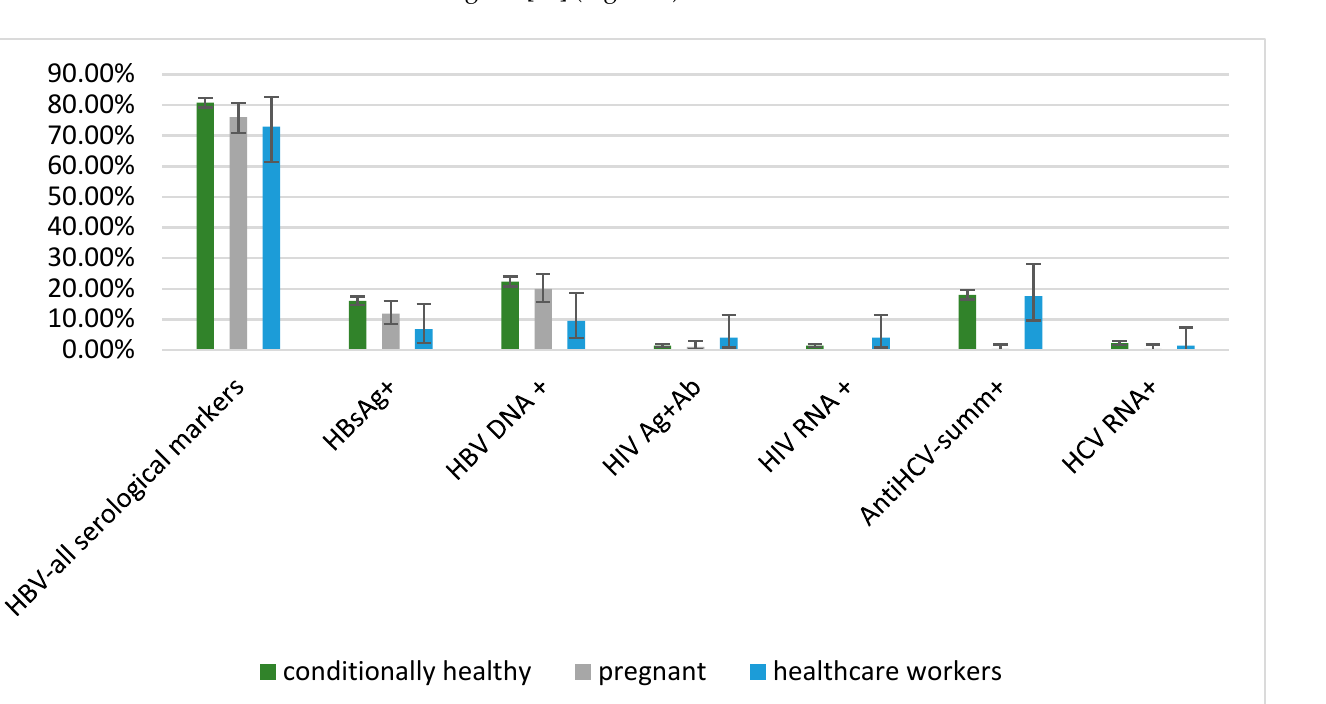
Figure 2. Comparative analysis of marker prevalence in blood-transmitted infections in different groups of the Republic of Guinea [28,38].